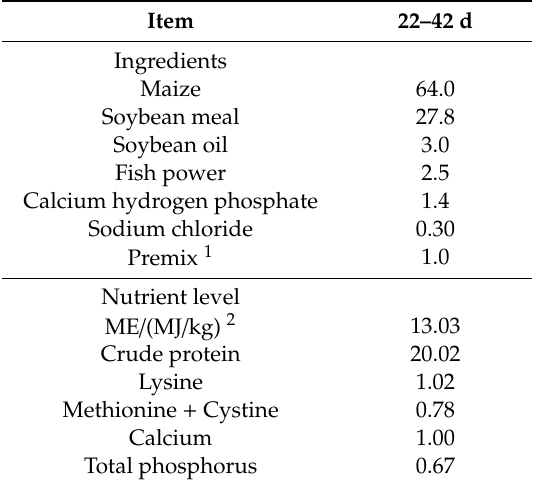
Table 1. Composition and nutrient levels of basal diets (air-dry basis;